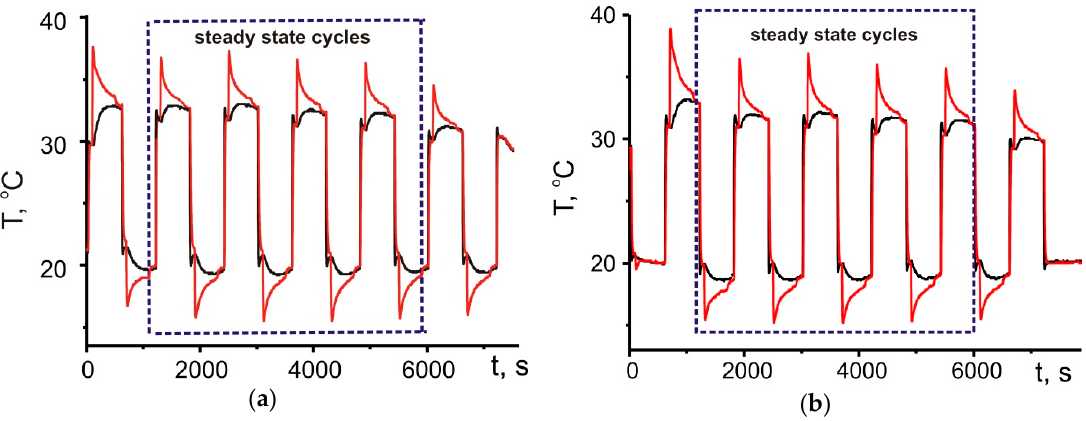
Figure 6. Temperature at the inlet (black) and outlet (red) of adsorbers A1 ( a ) and A2 ( b ). The duration of the adsorption–desorption stage is 400 s.